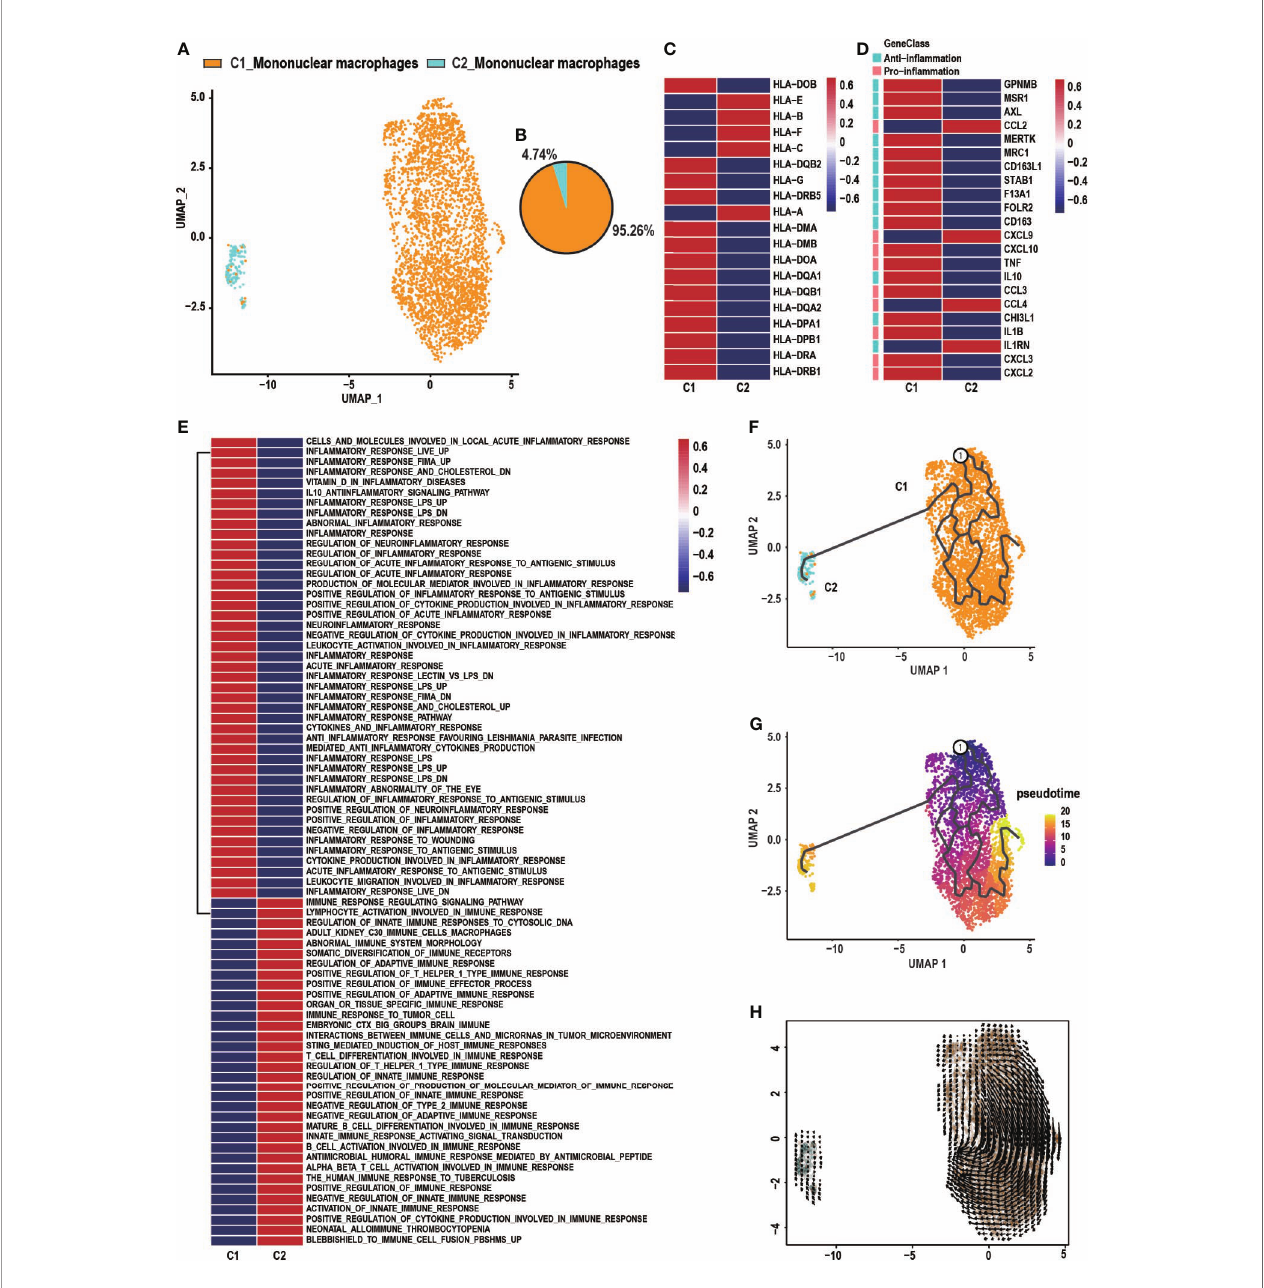
FIGURE 2 | Heterogeneity of macrophage populations in GCTB. (A) C1_Mononuclear macrophages and C2_Mononuclear macrophages were identi fi ed by UMAP analysis. (B) A pie chart depicting macrophage cell composition. (C) Heatmap of genes involved in antigen presenting by C1_Mononuclear macrophages and C2_Mononuclear macrophages. (D) Heatmap of genes associated with anti- and pro-in fl ammation properties of C1_Mononuclear macrophages and C2_Mononuclear macrophages. (E) GSVA analysis shows the function of C1_Mononuclear macrophages and C2_Mononuclear macrophages. (F, G) The differentiation and developmental trajectory of C1_Mononuclear macrophages and C2_Mononuclear macrophages in GCTB. (H) Velocity fi eld projected onto the UMAP plot of C1_Mononuclear macrophages and C2_Mononuclear macrophages. Arrows indicate the direction of the differentiation and the average velocity. GCTB, giant cell tumor of bone; UMAP, uniform manifold approximation and projection for dimension